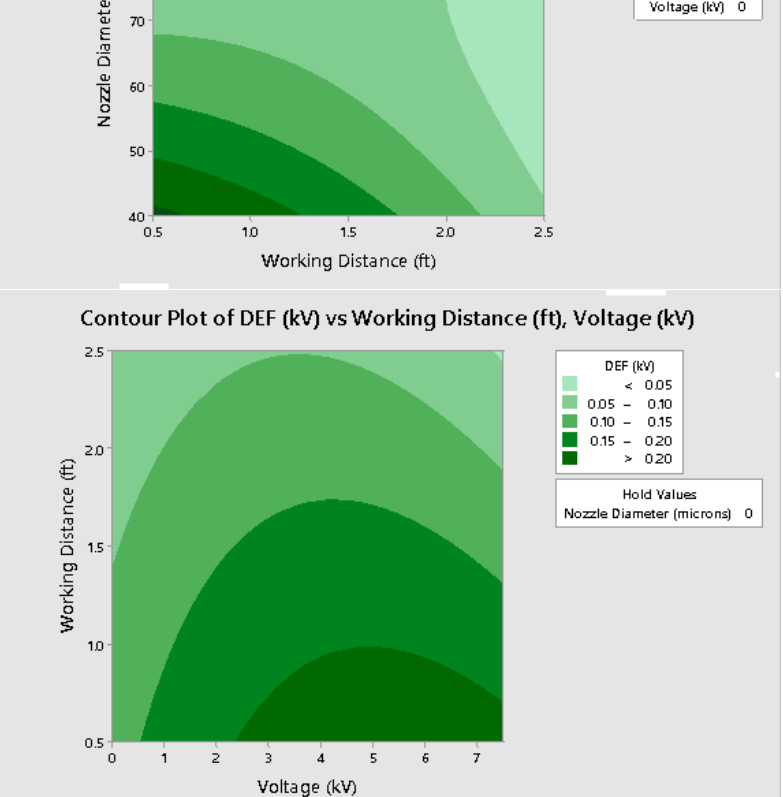
Figure A10. Aluminum: quantitative representation of average differential electric field vs. working distance (feet), nozzle sprayer size ( µ m), and charge voltage